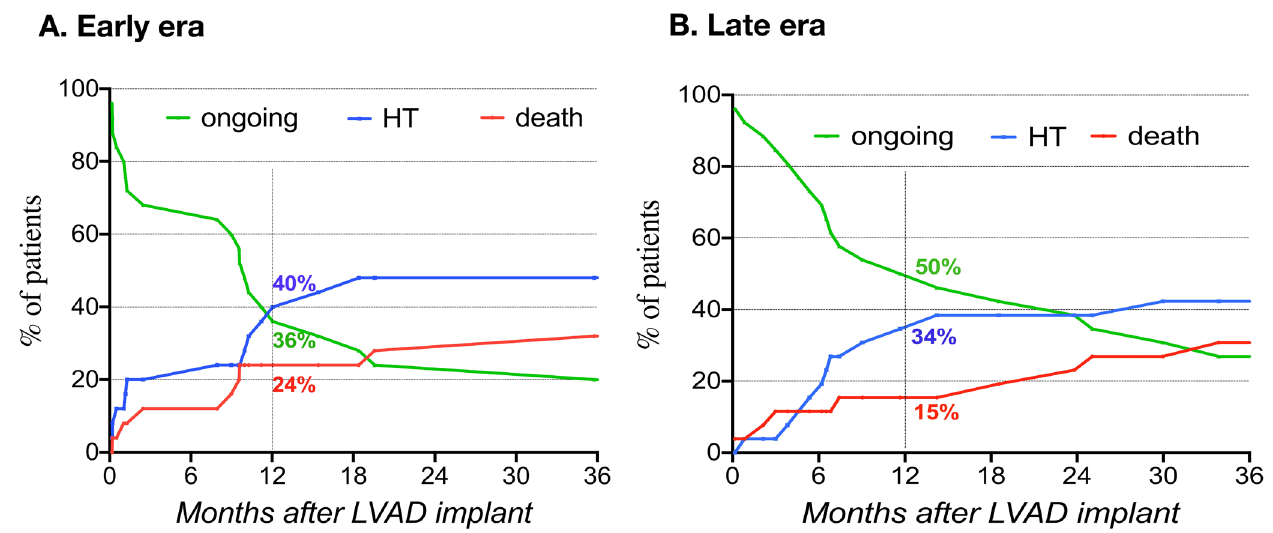
Fig. 1 - Competing outcomes after left ventricular device implantation in the early (A) and late (B)